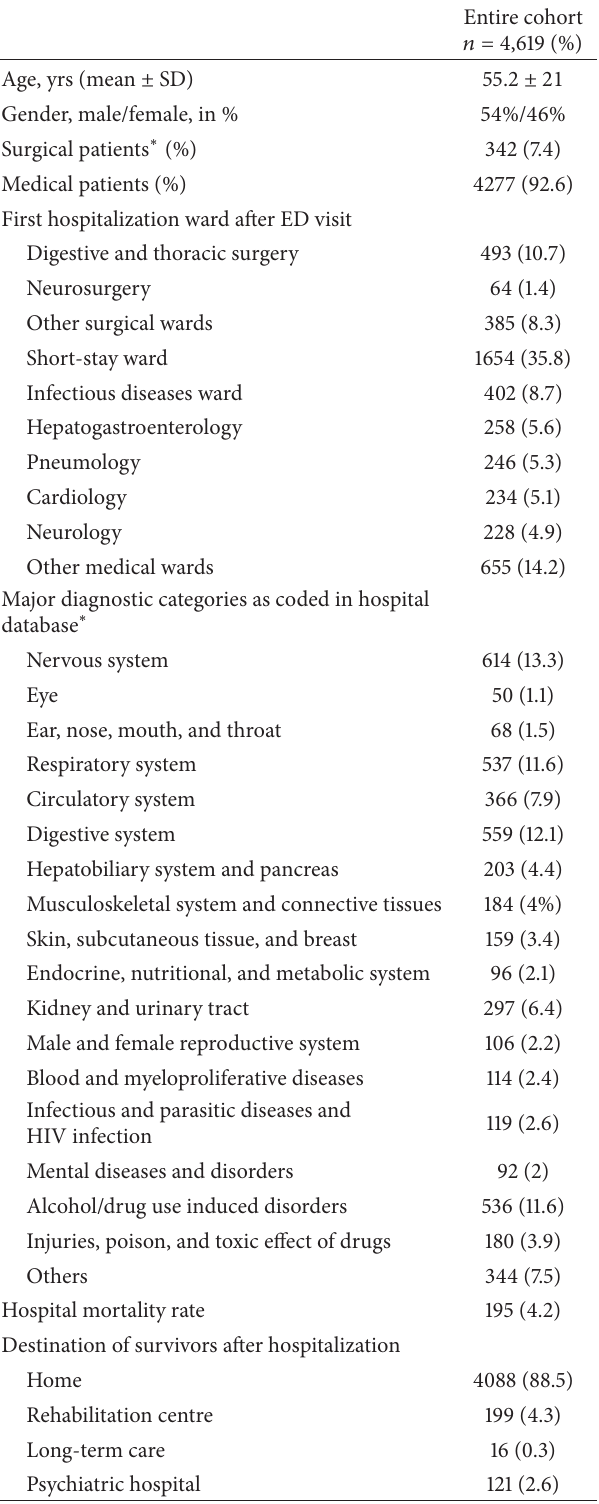
Table 1: Demographic characteristics of 4,619 consecutive patients admitted to the emergency department and then hospitalized on regular